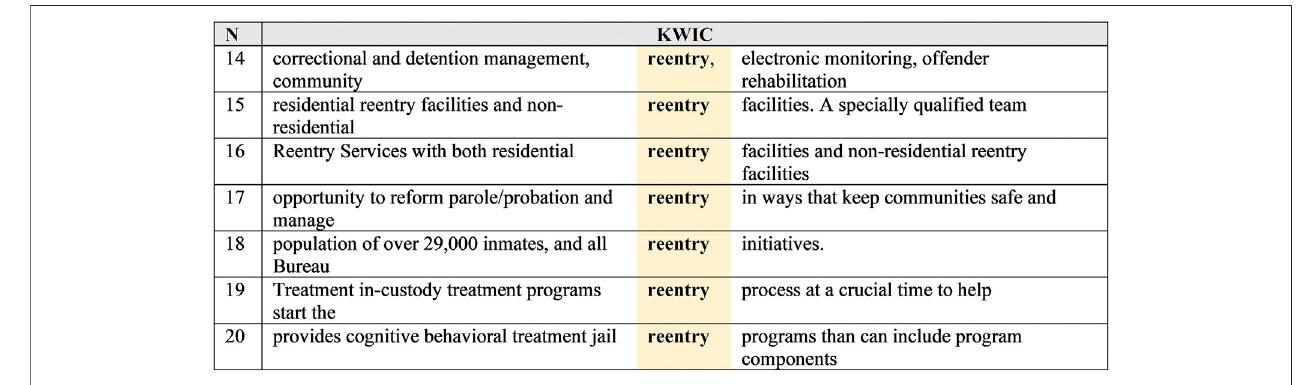
FIGURE 9 | The GEO corpus, “ reentry ” concordance lines 14 – 20.